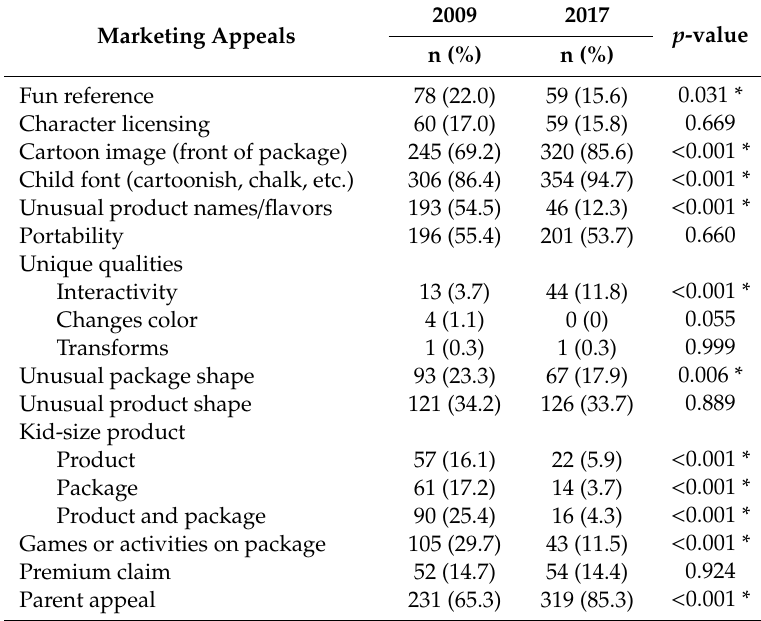
Table 5. Comparison of marketing appeals used with children’s food products from 2009 and